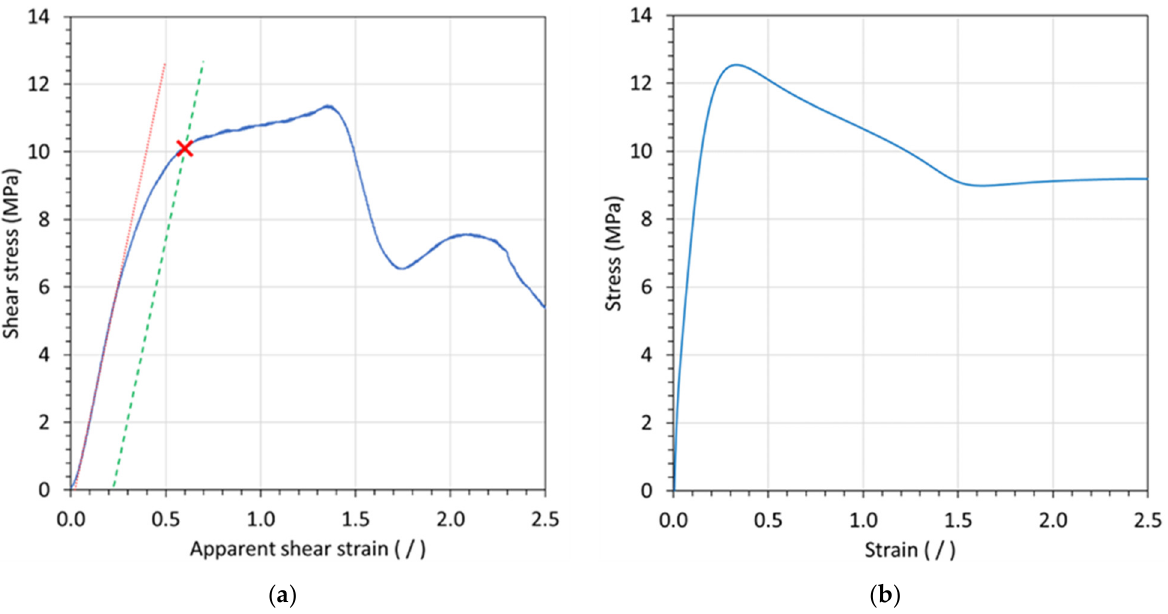
Figure 3. Typical stress–strain curve for ( a ) a punch-shear test and ( b ) a conventional tensile test using as ASTM D638 type I specimen (Polymer A2 tested in air at 60 